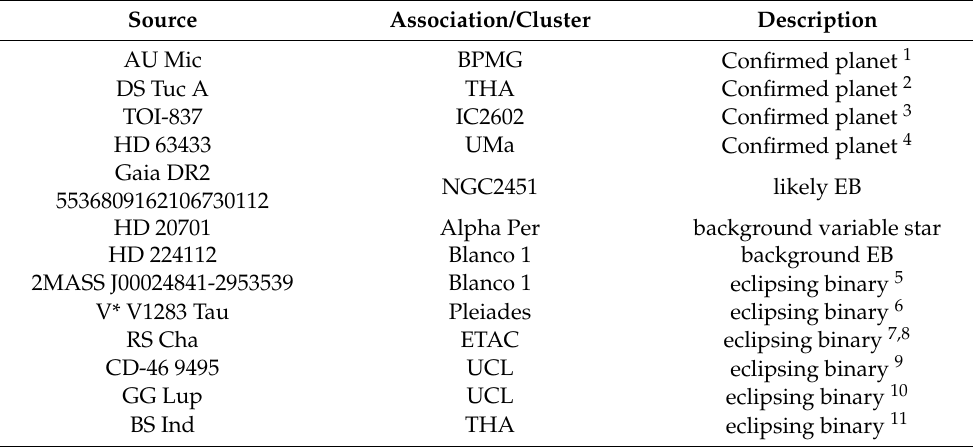
Table 2. The transit/eclipsing signals detected from the sample.